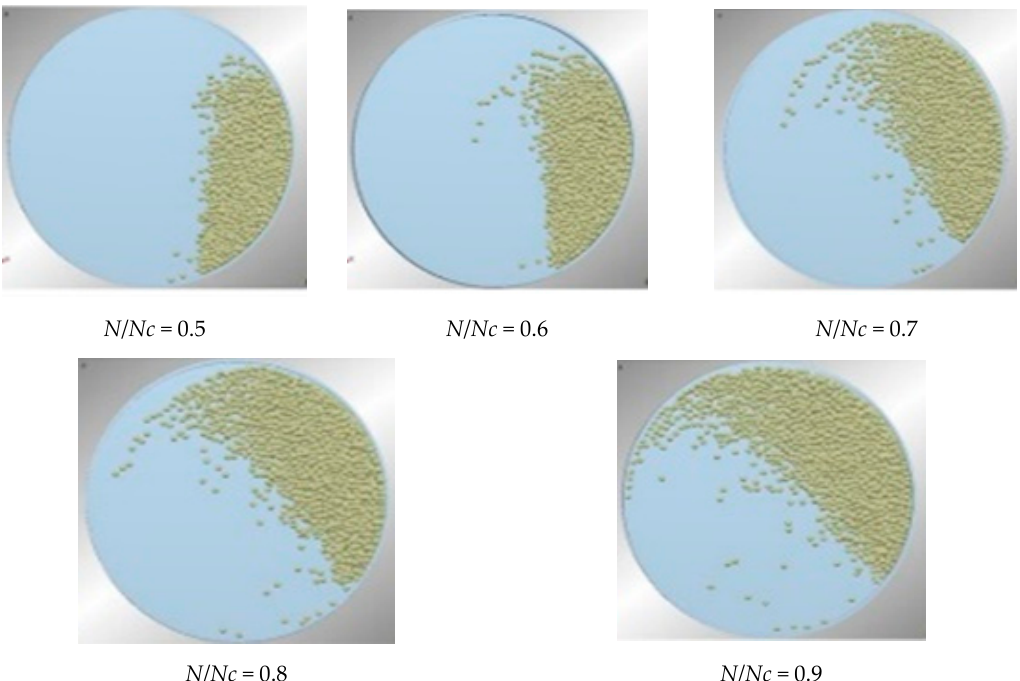
Figure 2. Motion state of pellets at 1.2 s at a charge ratio of 20% for different rotational speeds.